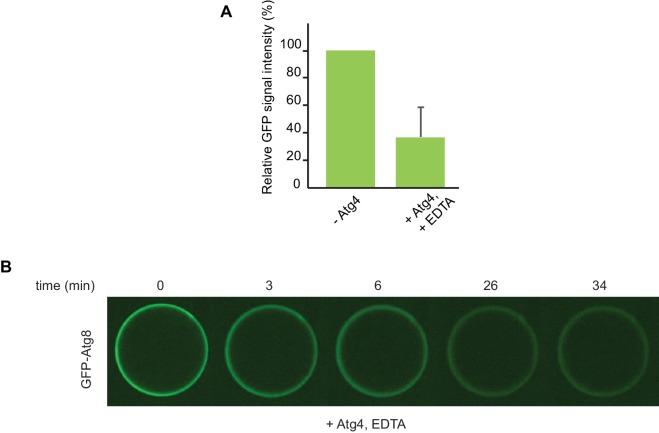
De-conjugation of lipidated Atg8 on the beads.(A) Quantification of three independent experiments performed using cargo mimetic beads prepared as in Figure 6A. Atg4 was added to cargo mimetic beads after an overnight conjugation reaction. The GFP-Atg8∆R117 signal at the beads was measured after 30 min of de-conjugation reaction. (B) Representative images of the Atg4 de-conjugation of Atg8 at the beads at the indicated time points.